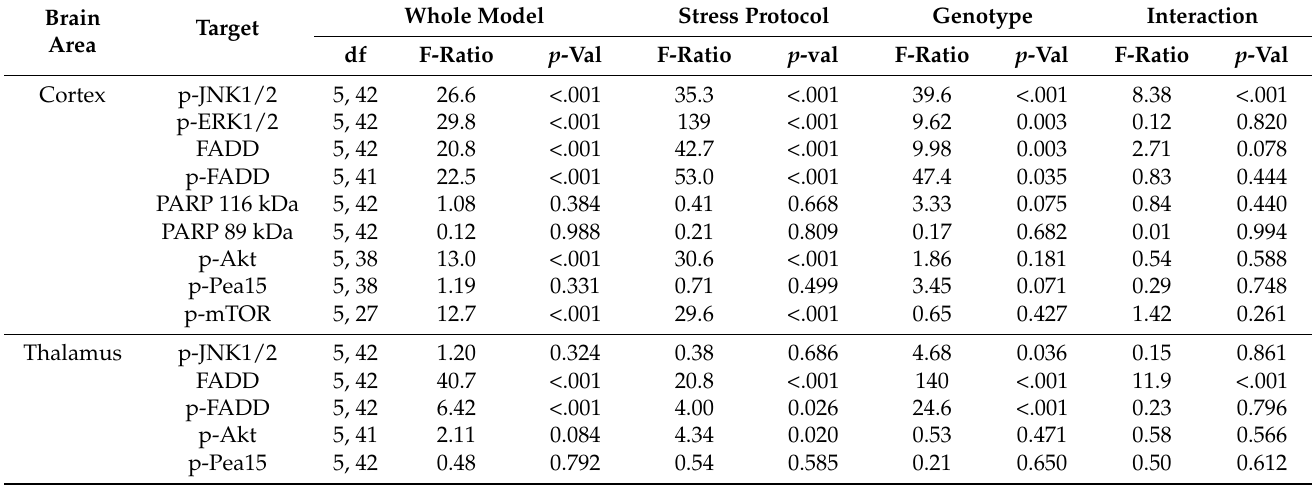
Table 1. Results of TW-ANOVA reporting the effects of the stress procedures, PDYN gene deletion, and their interaction on cortical and thalamic immunodensities of the studied